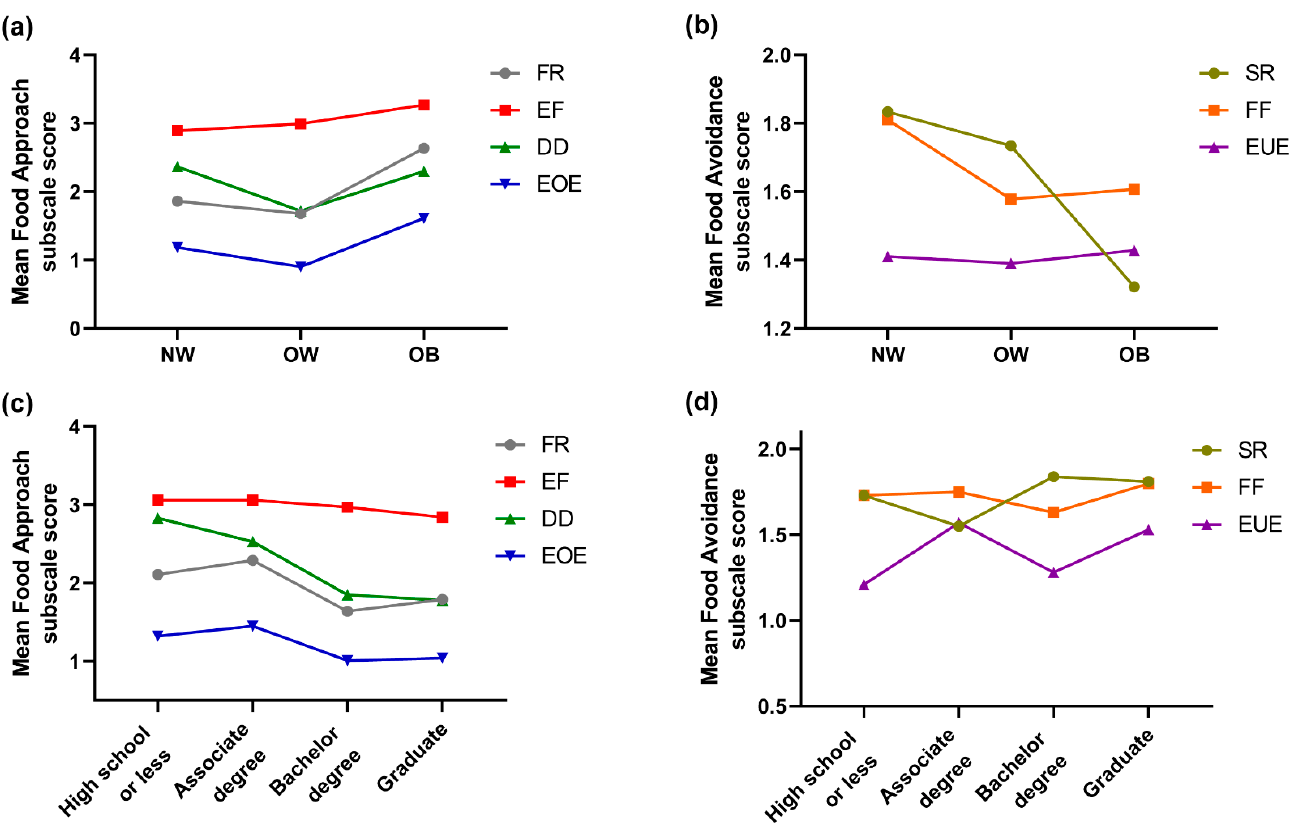
Figure 1. Mean scores of the subscales of food approach and food avoidance of the CEBQ based on ( a , b ) weight and ( c , d ) maternal education category.